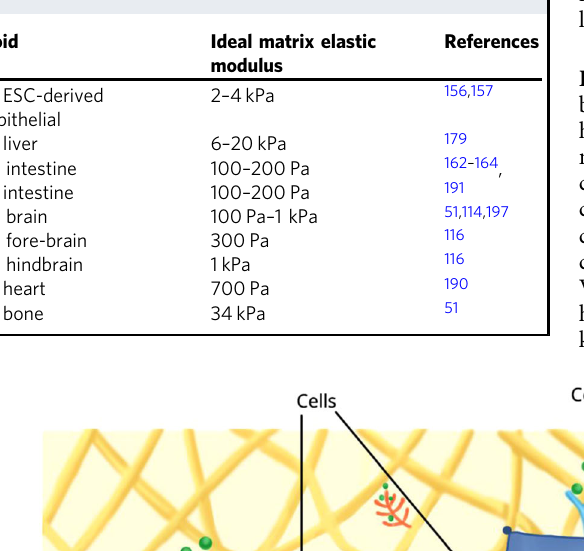
Table 2 Ideal elastic moduli for generating organoids from different organs.